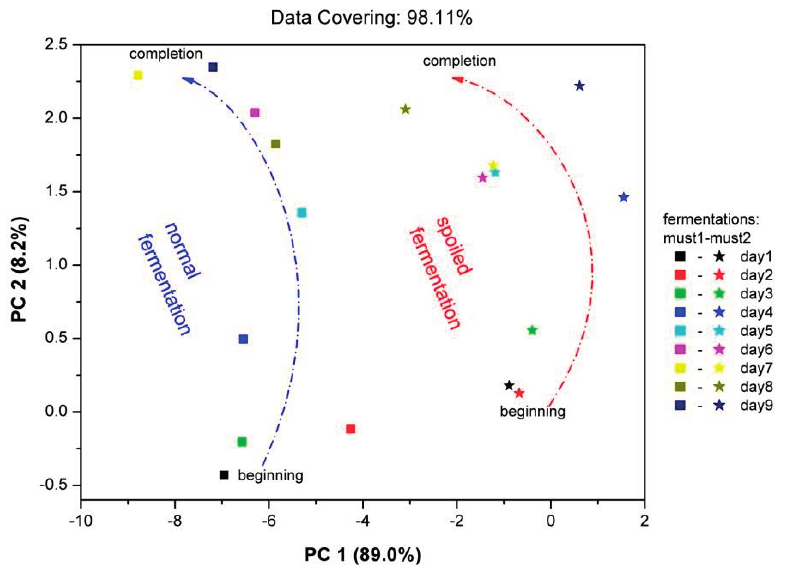
Figure 9. PCA analysis of the sensor array. Data processed: equilibrium responses during the fermentation